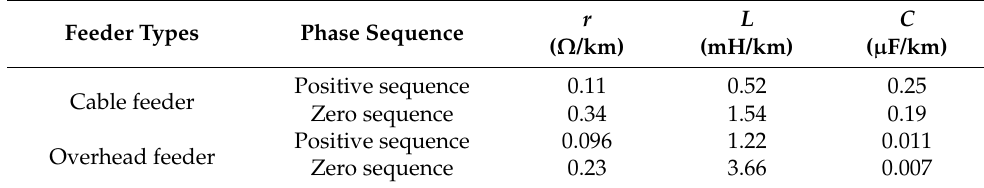
Table 2. Parameters of the feeders (per kilometer).